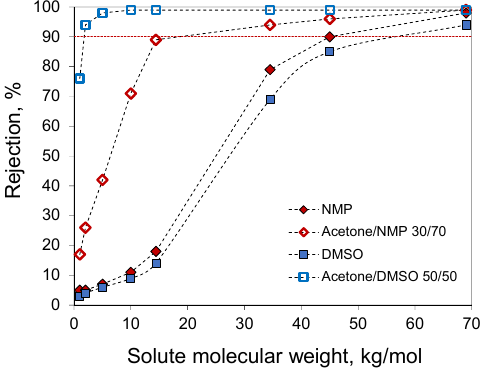
Figure 14. Molecular weight cut-off curves obtained with membranes prepared from 20% PAN solutions in NMP, Acetone/NMP 30/70, DMSO, and Acetone/DMSO 50/50.